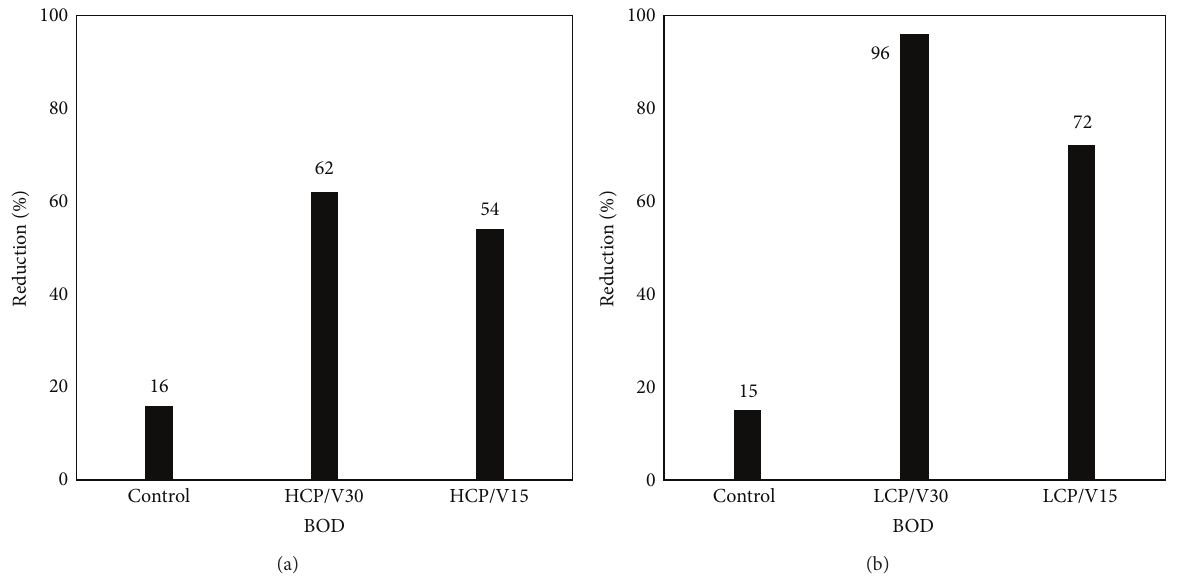
Figure 4: Reduction of BOD%: (a) high concentration POME (HCP) and (b) low concentration POME.